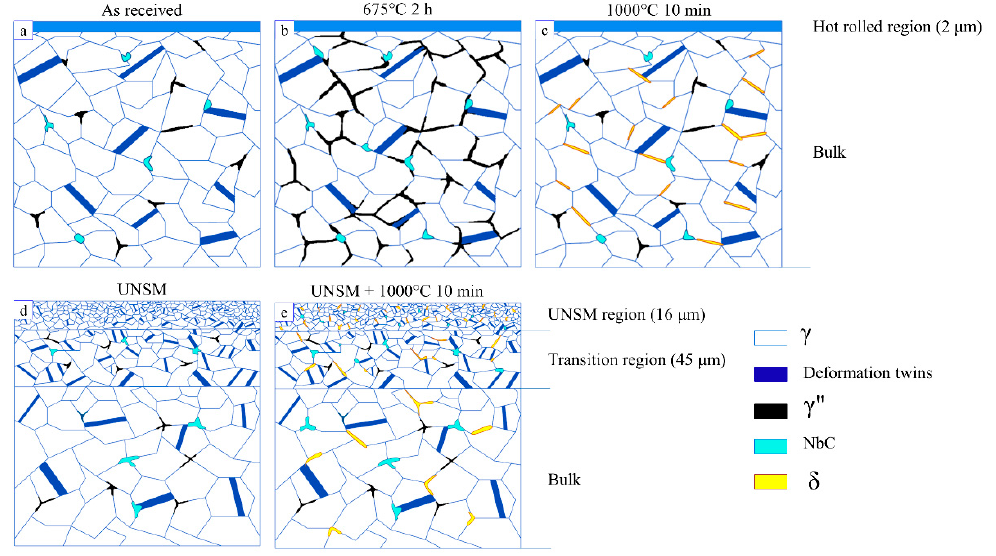
Figure 6. Schematic of the different microstructure as a result of the thermal and UNSM processing of Inconel 718: ( a ) As-received sample, ( b ) I1 sample, ( c ) I2 sample, ( d ) I3 sample and, ( e ) I4 sample.